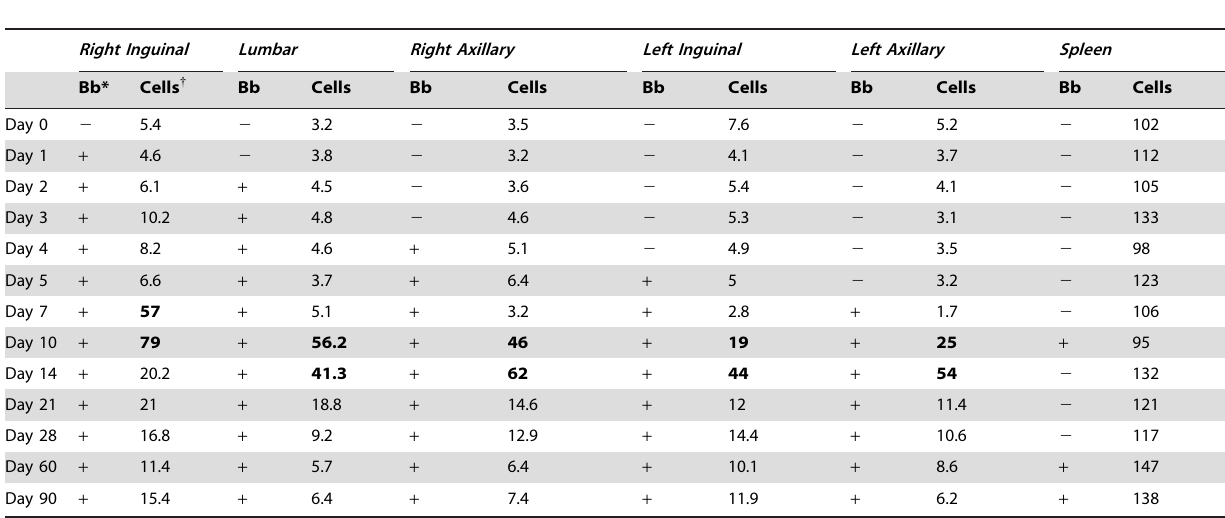
Table 1. B. burgdorferi presence correlates with lymphadenopathy in mice infected with host-adapted spirochetes.